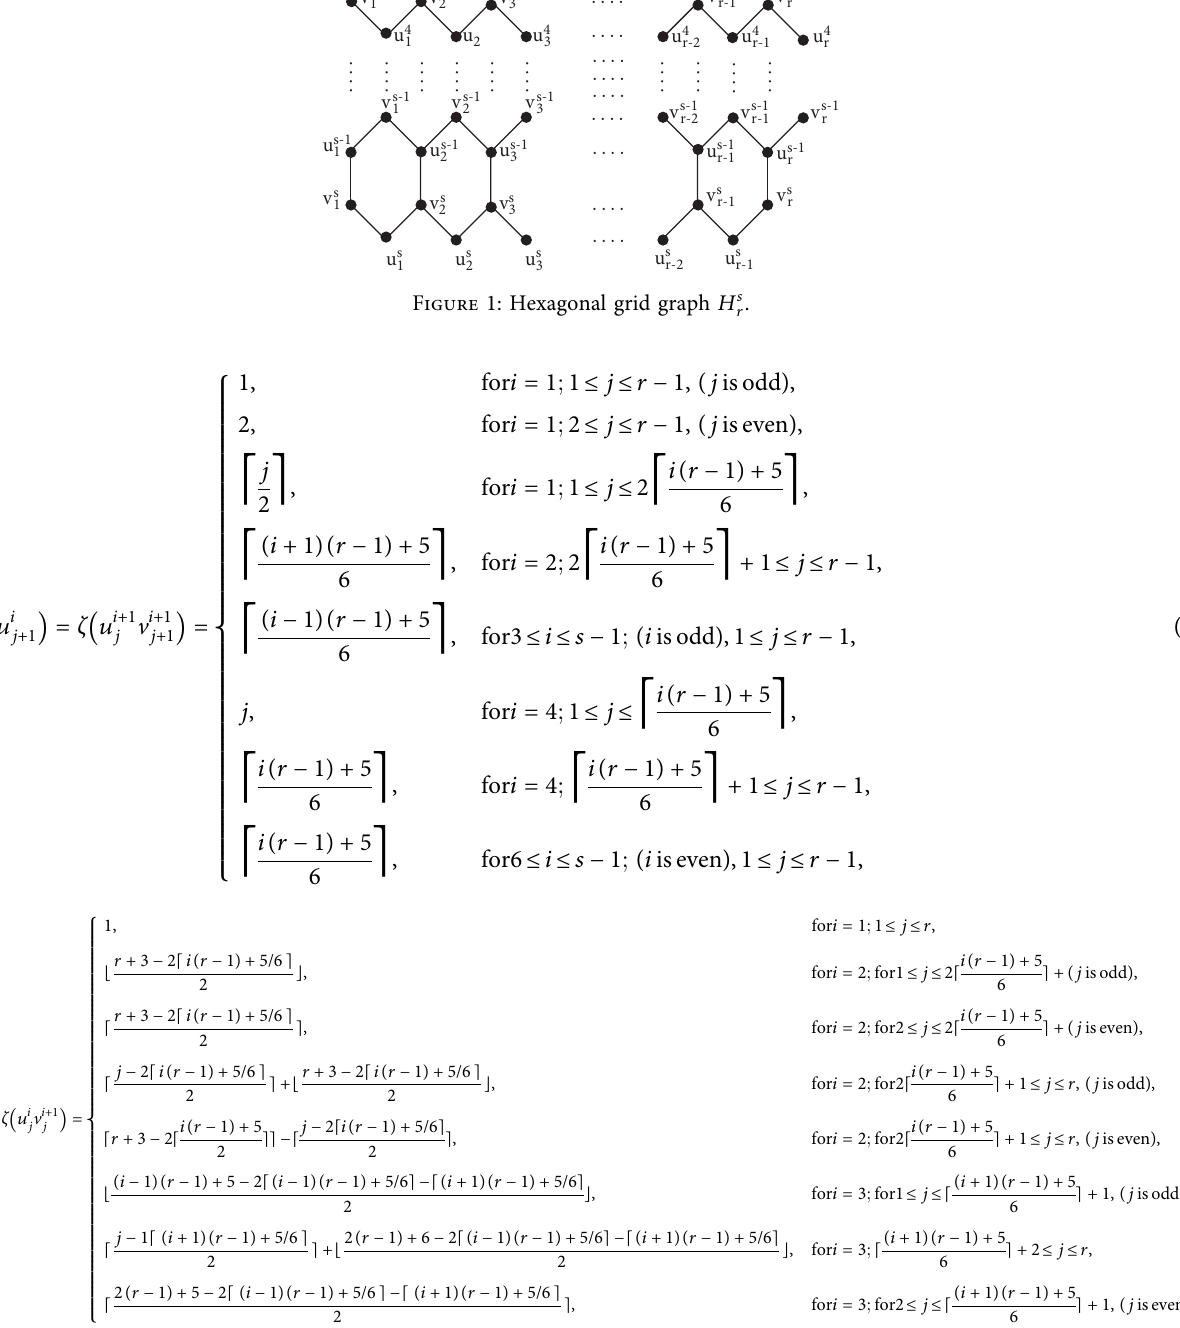
Figure 1: Hexagonal grid graph H s